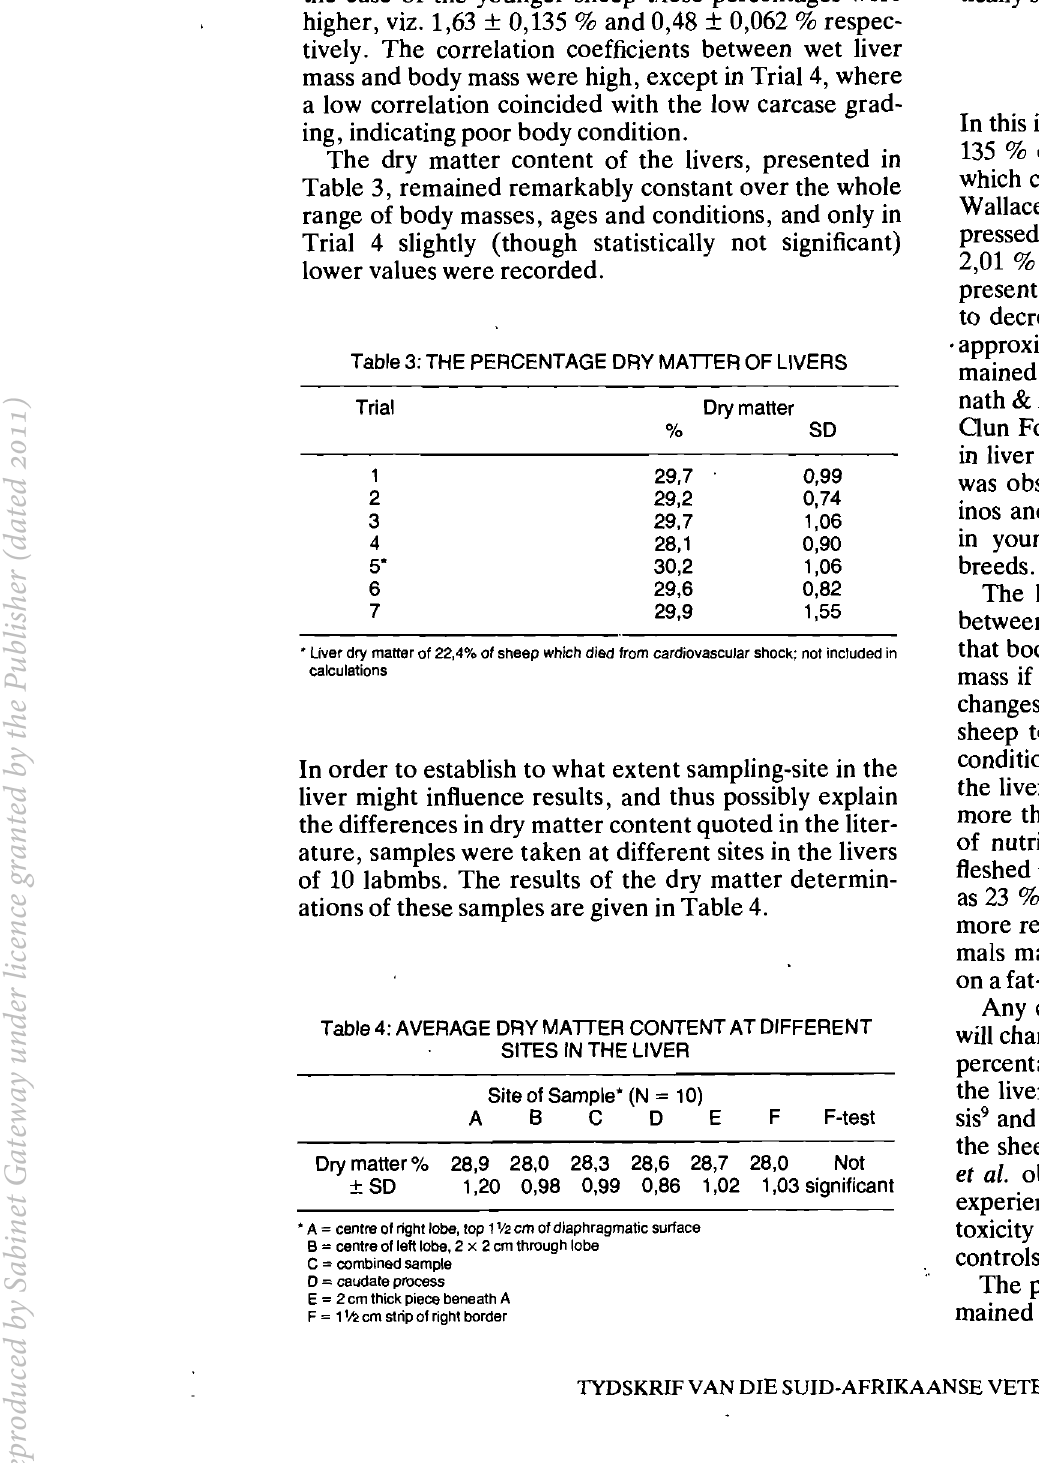
Table 4: AVERAGE DRY MATTER CONTENT AT DIFFERENT SITES IN THE LIVER Site of Sample' (N = 10) ABC 0 E F